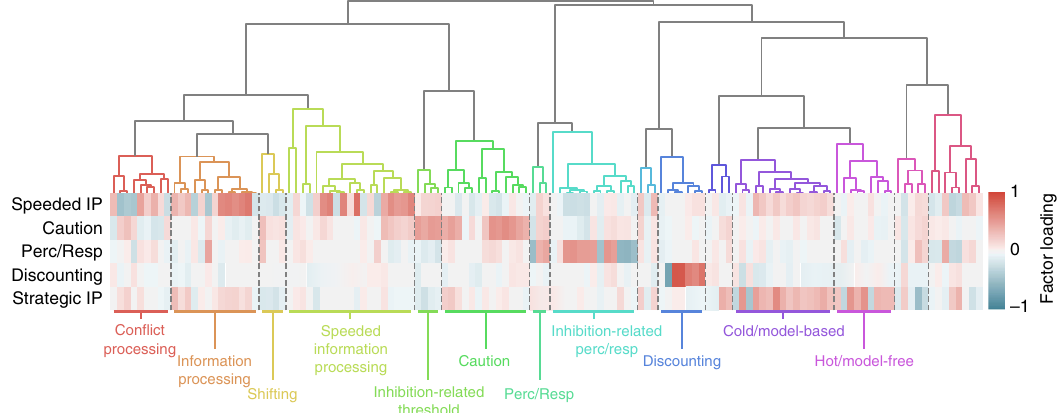
Fig. 4 Task ontology. Identical to Fig. 3, except operating over 129 task DVs, which are projected onto 5 factors and separated into 15 clusters. IP: information